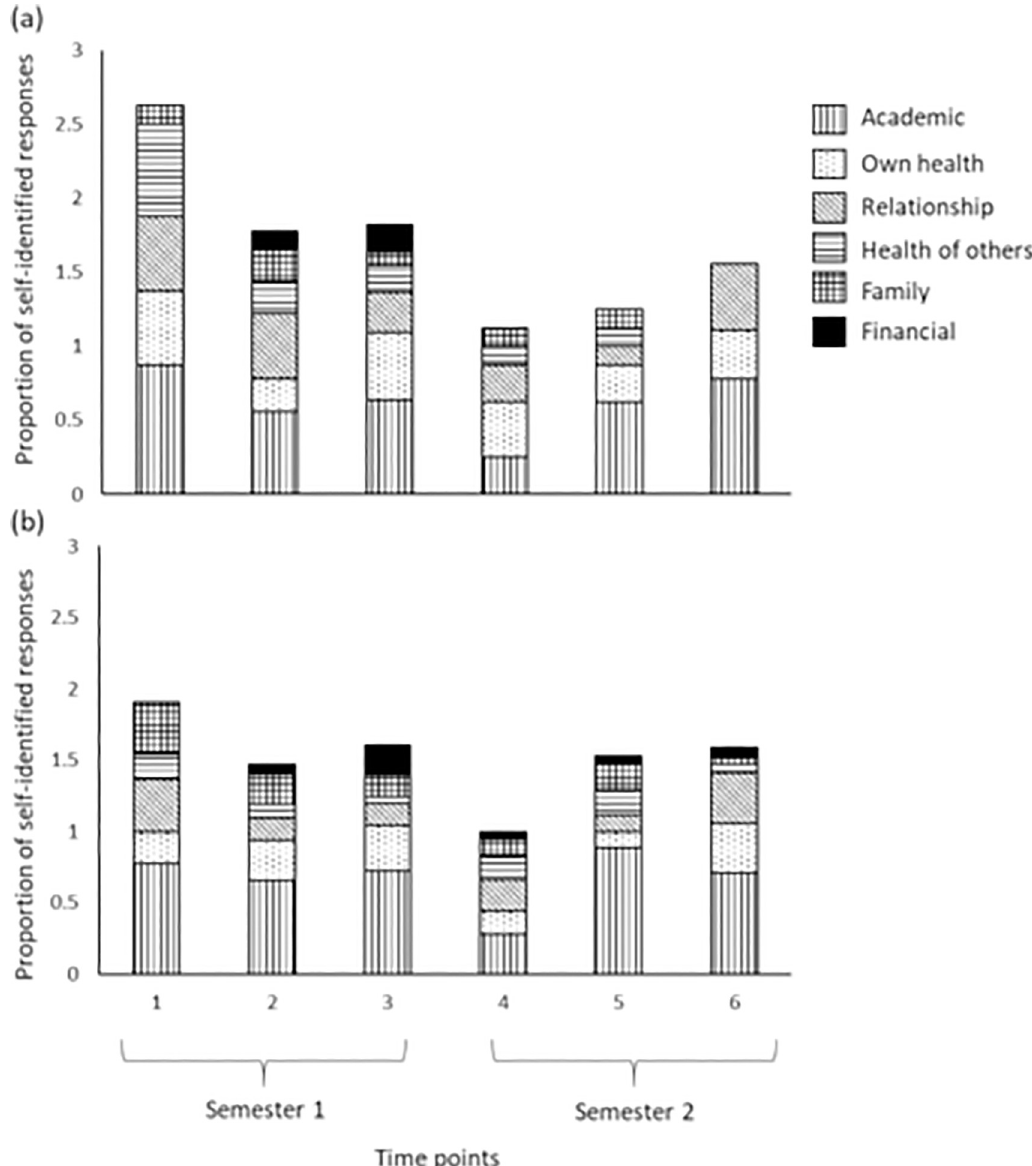
Fig 2. Stacked bar plot for proportion of self-identified responses for types of stressors across time. (a) In men and (b) women undergraduate student participants.